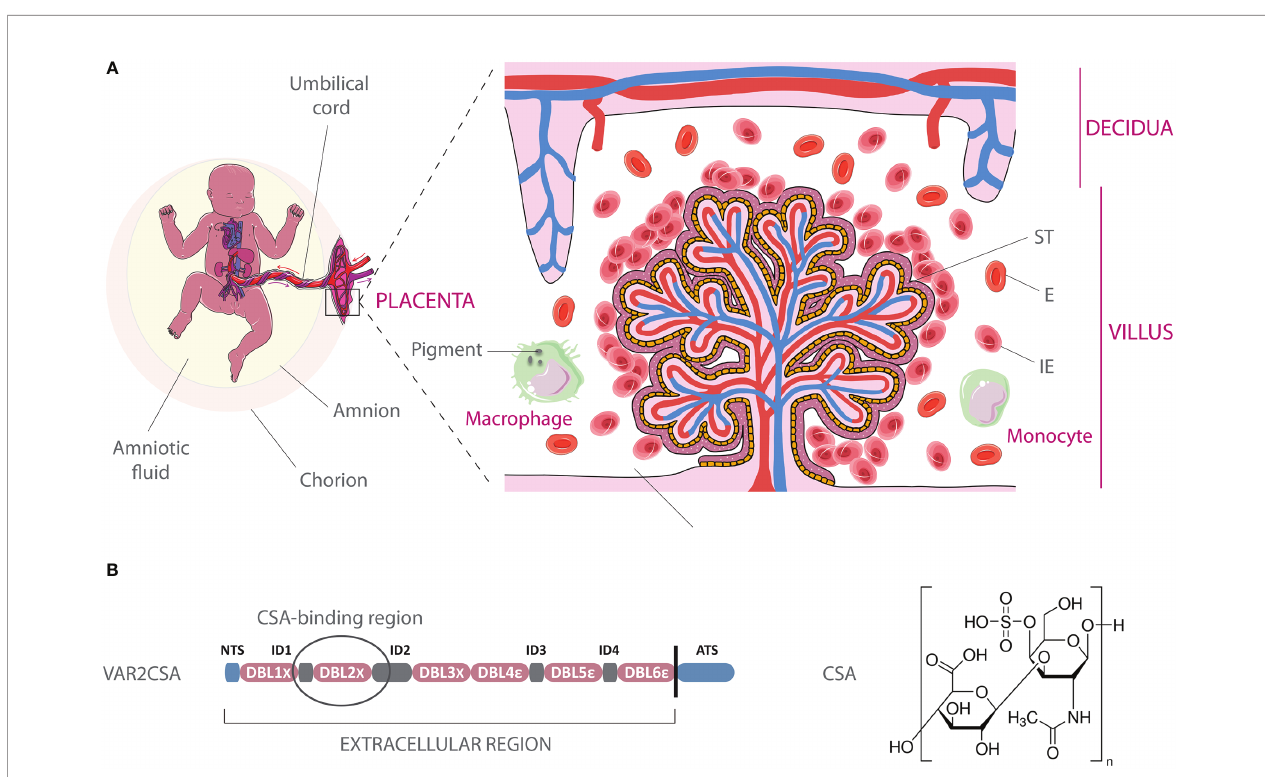
FIGURE 1 | Infected erythrocyte sequestration within the intervillous space of the placenta. (A) Schematic representation of infected erythrocytes (IE) adhering to the syncytiotrophoblastic lining of the fetal villus, with increased presence of macrophages and monocytes in the maternal blood. Parasite pigments (hemozoin) remain visible in macrophages following IEs phagocytosis. The natural transfer of gases and nutrients between maternal blood in the intervillous space and fetal blood circulating in the villi is impaired by IEs sequestration. E, Erythrocyte; ST, syncytiotrophoblast. (B) Architecture of the VAR2CSA protein and chemical structure of chondroitin-4-sulfate A. The circled region within VAR2CSA (ID1-ID2a) represents the CSA-binding region. The art pieces used in this fi gure were modi fi ed from Servier Medical Art by Servier, licensed under a Creative Commons Attribution 3.0 Unported License